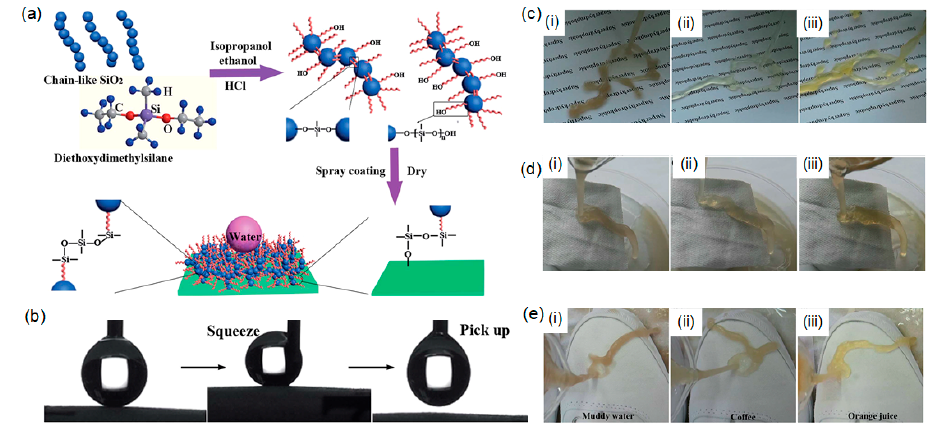
Figure 14. ( a ) Schematic illustration of the fabrication of environmentally safe and transparent superhydrophobic coatings on various substrates via the nanoparticle self-assembly method. ( b ) The dropping, squeezing, and picking up of a water droplet, showing the low adhesive force on superhydrophobic paper. Three common liquid contaminants (( i ) muddy water, ( ii ) coffee, and ( iii ) orange juice) were poured on prepared superhydrophobic coatings on ( c ) paper, ( d ) fabric, and ( e ) a shoe surface, to test the antifouling ability of the coating. Reproduced from [107] with permission; Copyright RSC 2014.